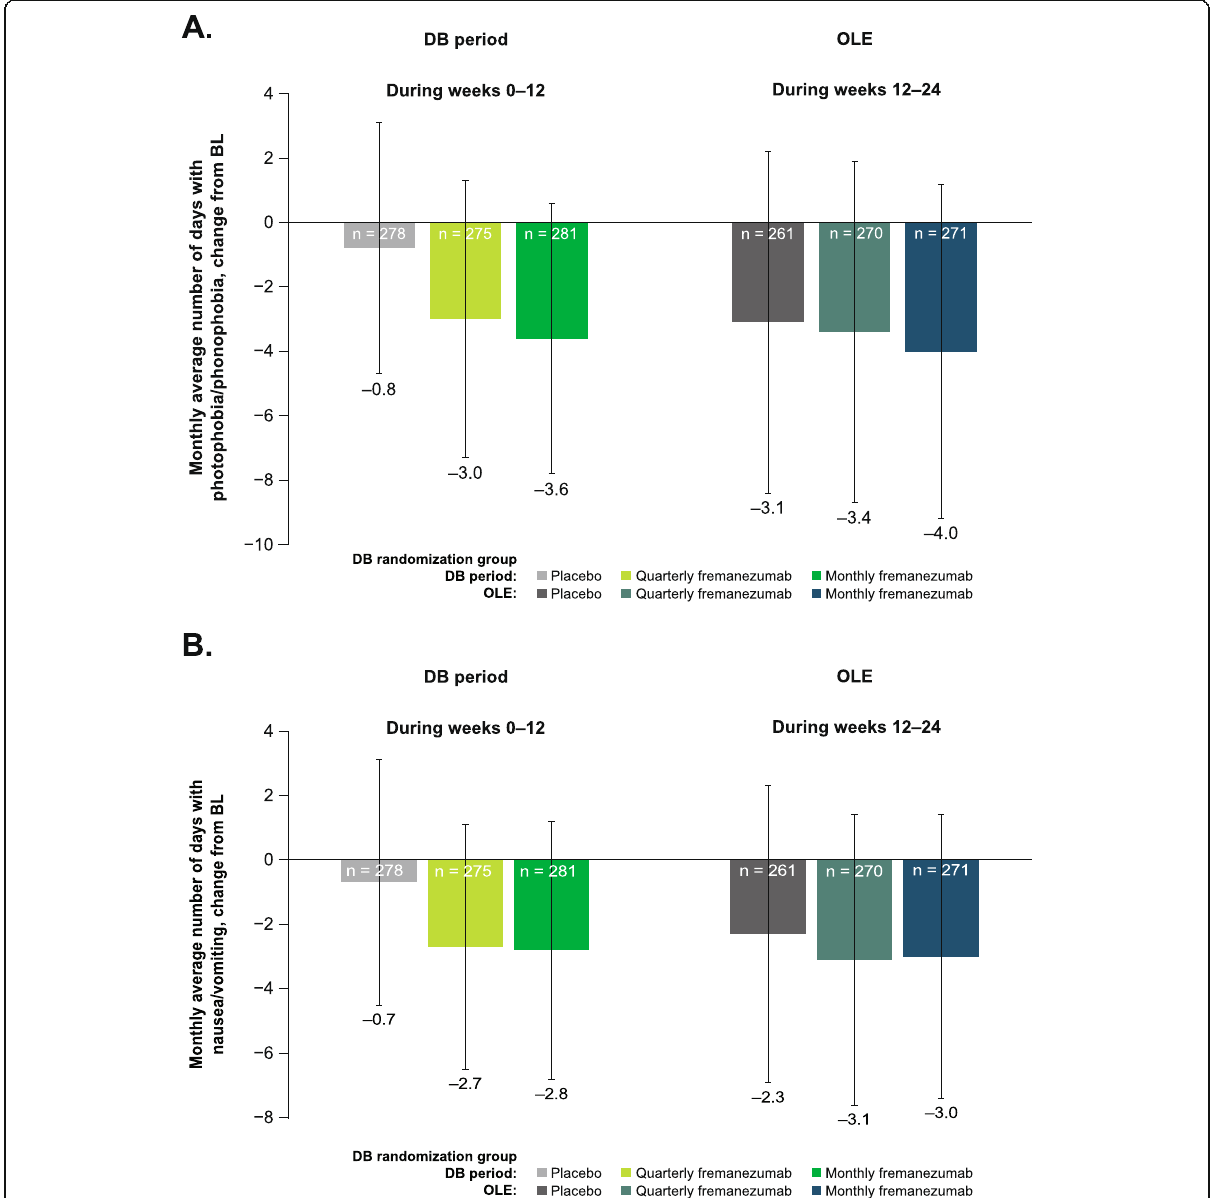
Fig. 7 Mean change from BL in days with a photophobia/phonophobia and b nausea/vomiting in the DB period and the OLE (mITT). a BL, baseline; DB, double-blind; OLE, open-label extension; mITT, modified intent-to-treat. a All patients in the OLE received fremanezumab 225 mg